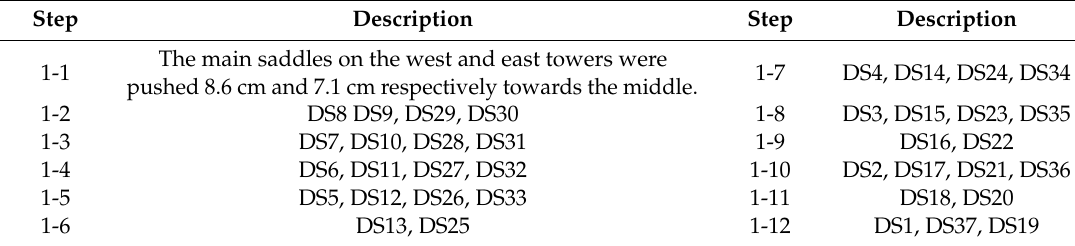
Table 2. Specific step of tensioning round